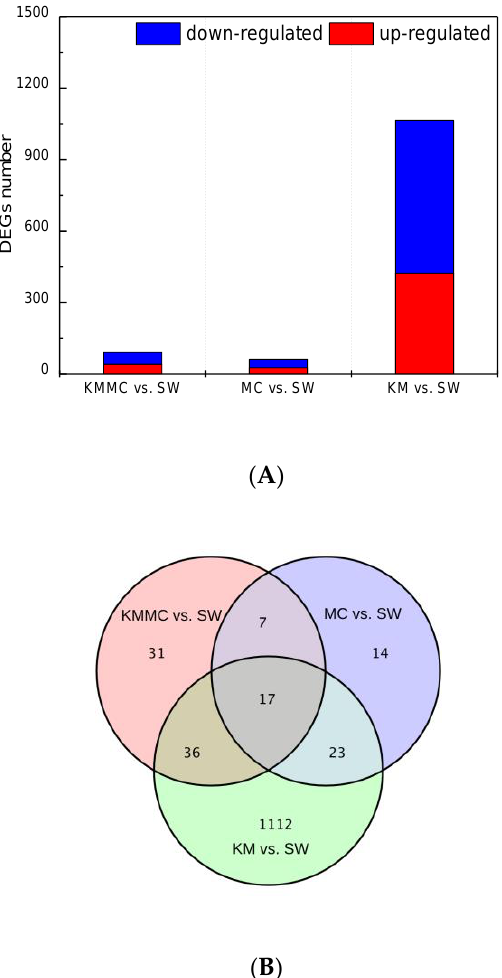
Figure 5. The number of DEGs in fish gills in each treatment group. ( A ) The numbers of up-regulated genes and down-regulated genes in each treatment group. ( B ) Venn diagram.